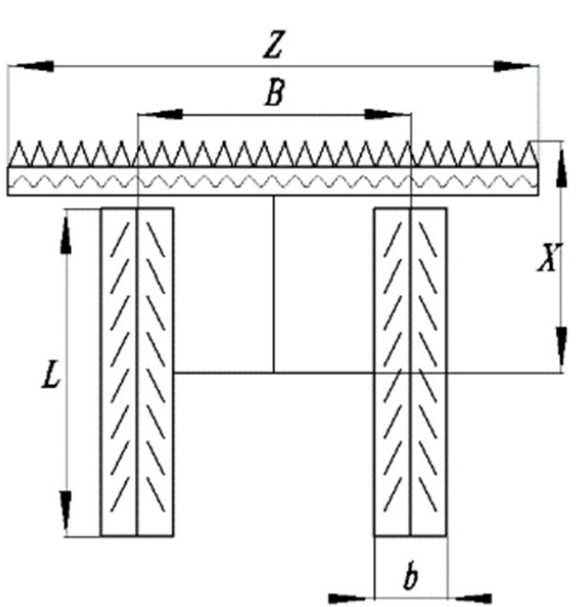
Figure 5. Structure model of track harvester. Note: Z is cutting width, mm; B is track gauge, mm; b is the track width, mm; L is track grounding length,